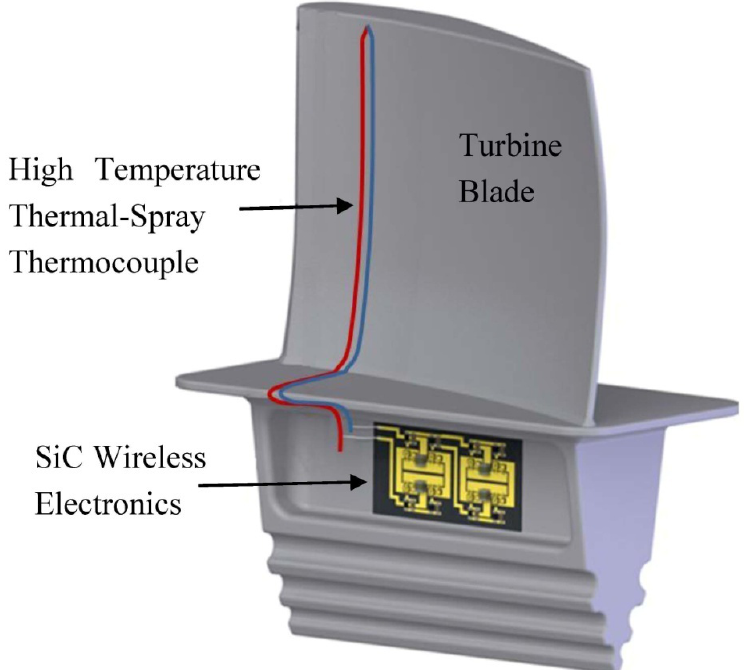
Figure 1. Conceptual configuration of proposed wireless temperature sensing system for turbine blade health